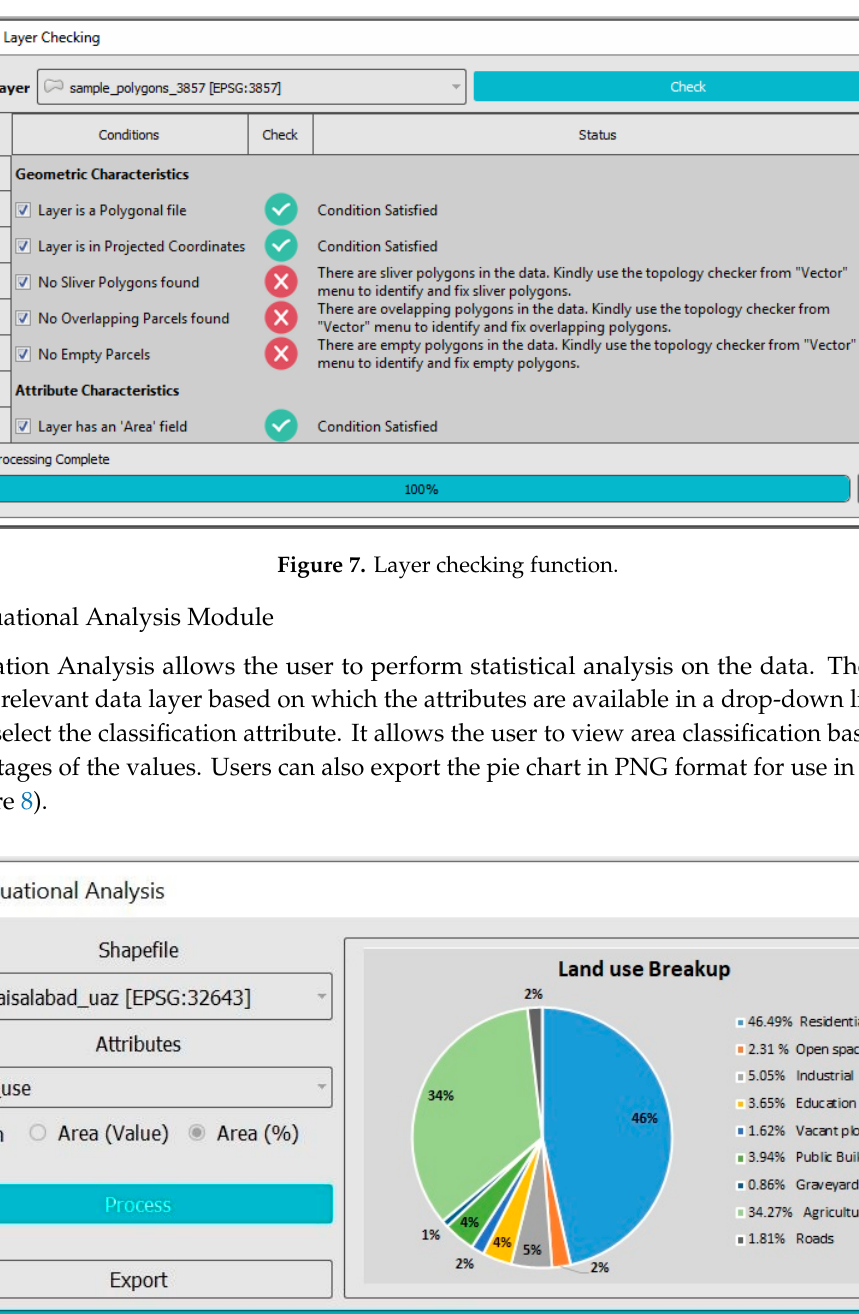
Figure 8. Descriptive statistical summary of layer attributes.